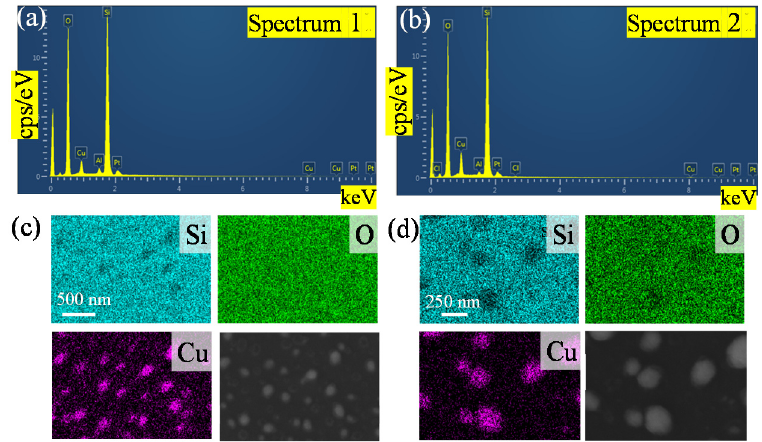
Figure 2. Energy dispersive X-ray spectroscopy (EDS) elemental characterization of the copper nanoparticles fabricated with the different deposition times at 900 °C; ( a , c ) the EDS spectra of the copper for a deposition time of 90 s; ( b , d ) the EDS spectra of the copper for a deposition time of 120 s.